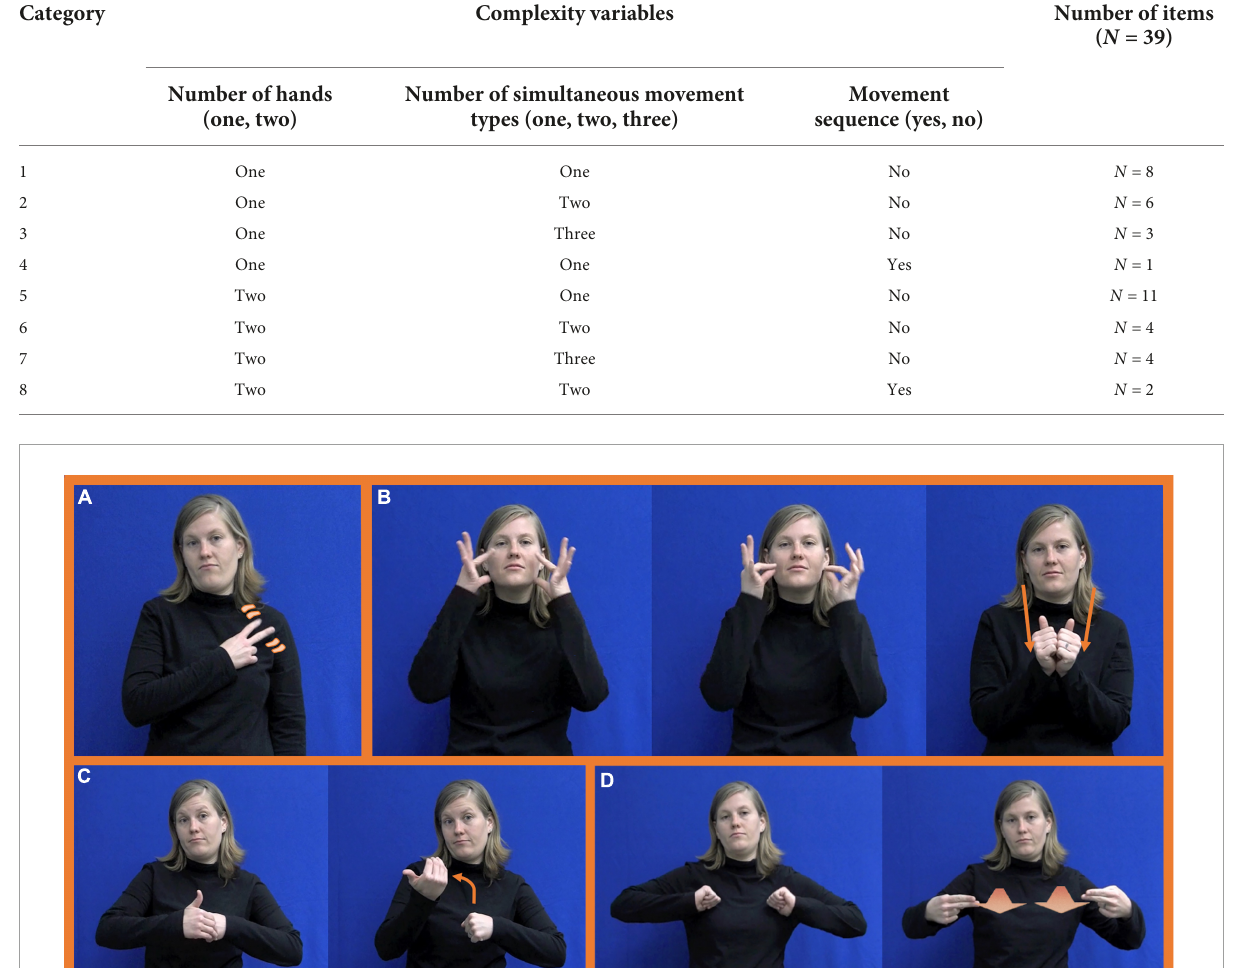
TABLE 1 Combinatorial possibilities of complexity in the pseudosign stimuli.